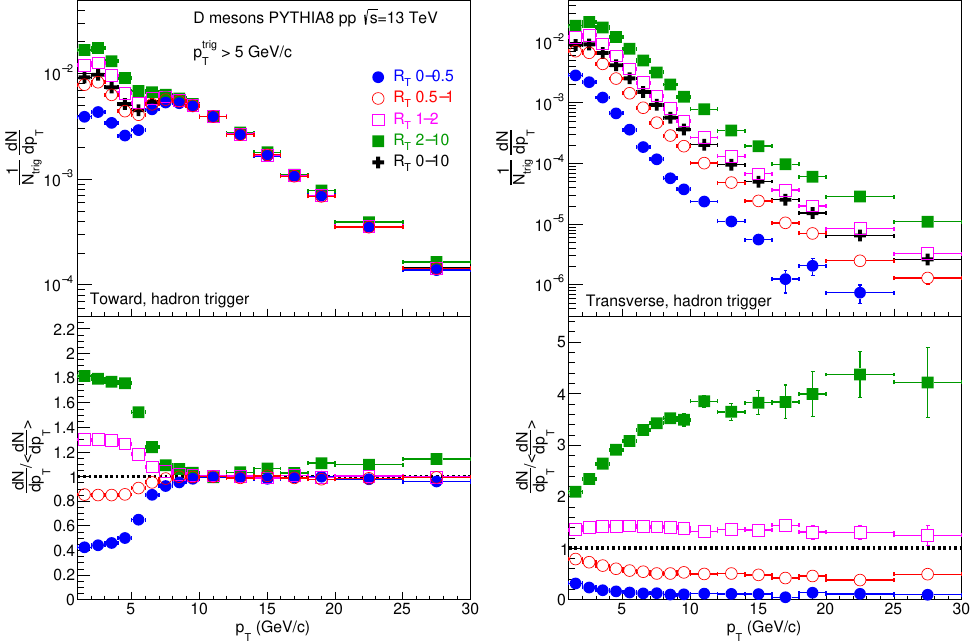
Figure 3. Per-trigger D-meson production with charged-hadron triggers as a function of p T for different R T classes in the toward ( left ) and transverse ( right ) regions. The top panels show the yields, while the bottom panels show their ratios over the R T -integrated per-trigger